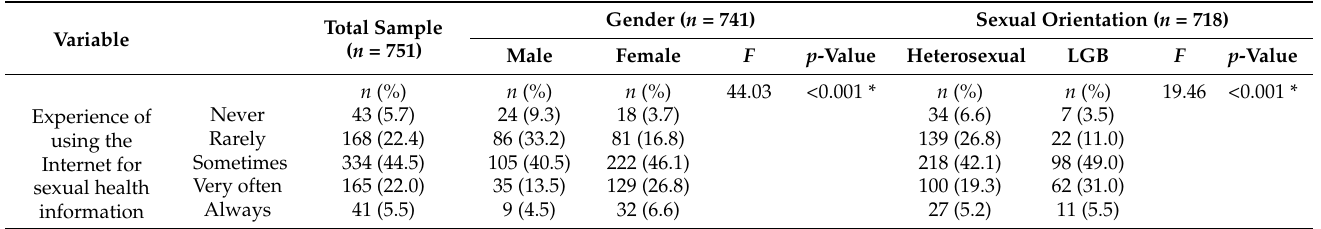
Table 2. Frequencies of experience of using the Internet for sexual health information, accounted for by gender and sexual